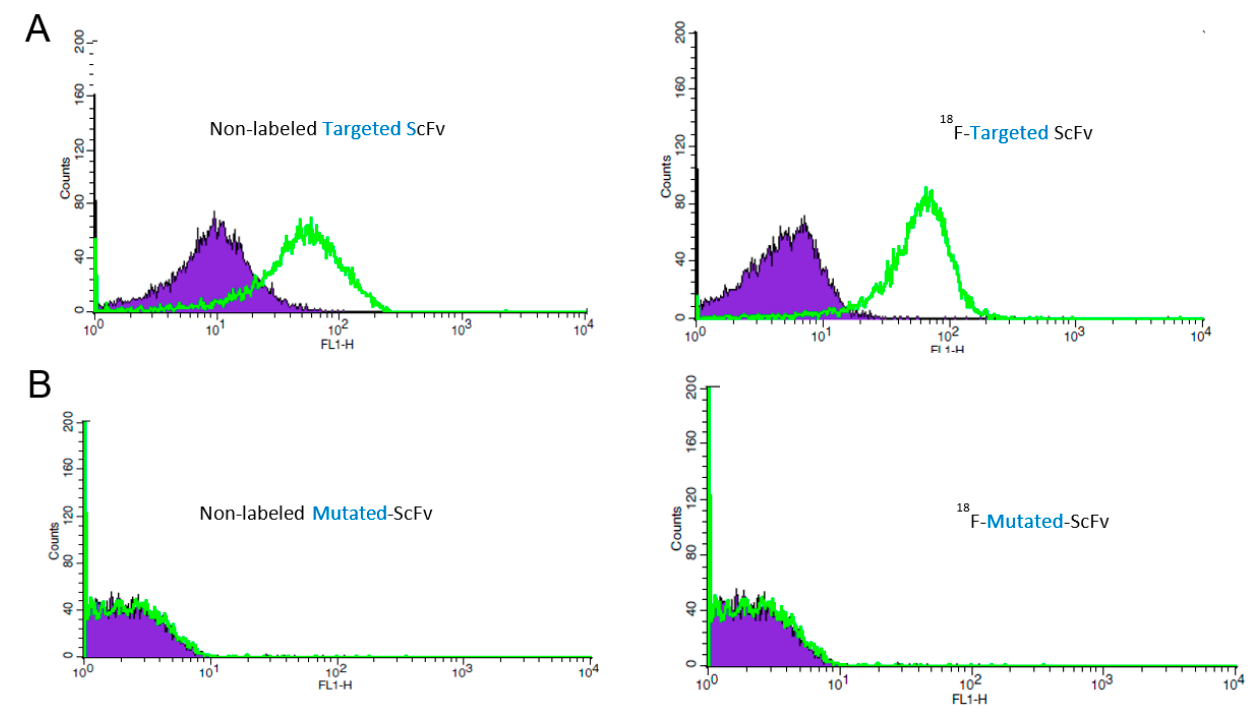
Figure 1. Flow cytometry analysis comparing the binding of non-labelled targeted-ScFv and [ 18 F]FBEM radiolabelled targeted-ScFv. The purple filled curve represents antibody binding to non- activated platelets, and the green curve shows binding to activated platelets. ( A ) shows that scFvs’ ability to bind to activated platelets is not altered by the [ 18 F]FBEM radiolabelling process. ( B ) shows that the mutated-ScFv does not bind to activated platelets. Representative results are shown.